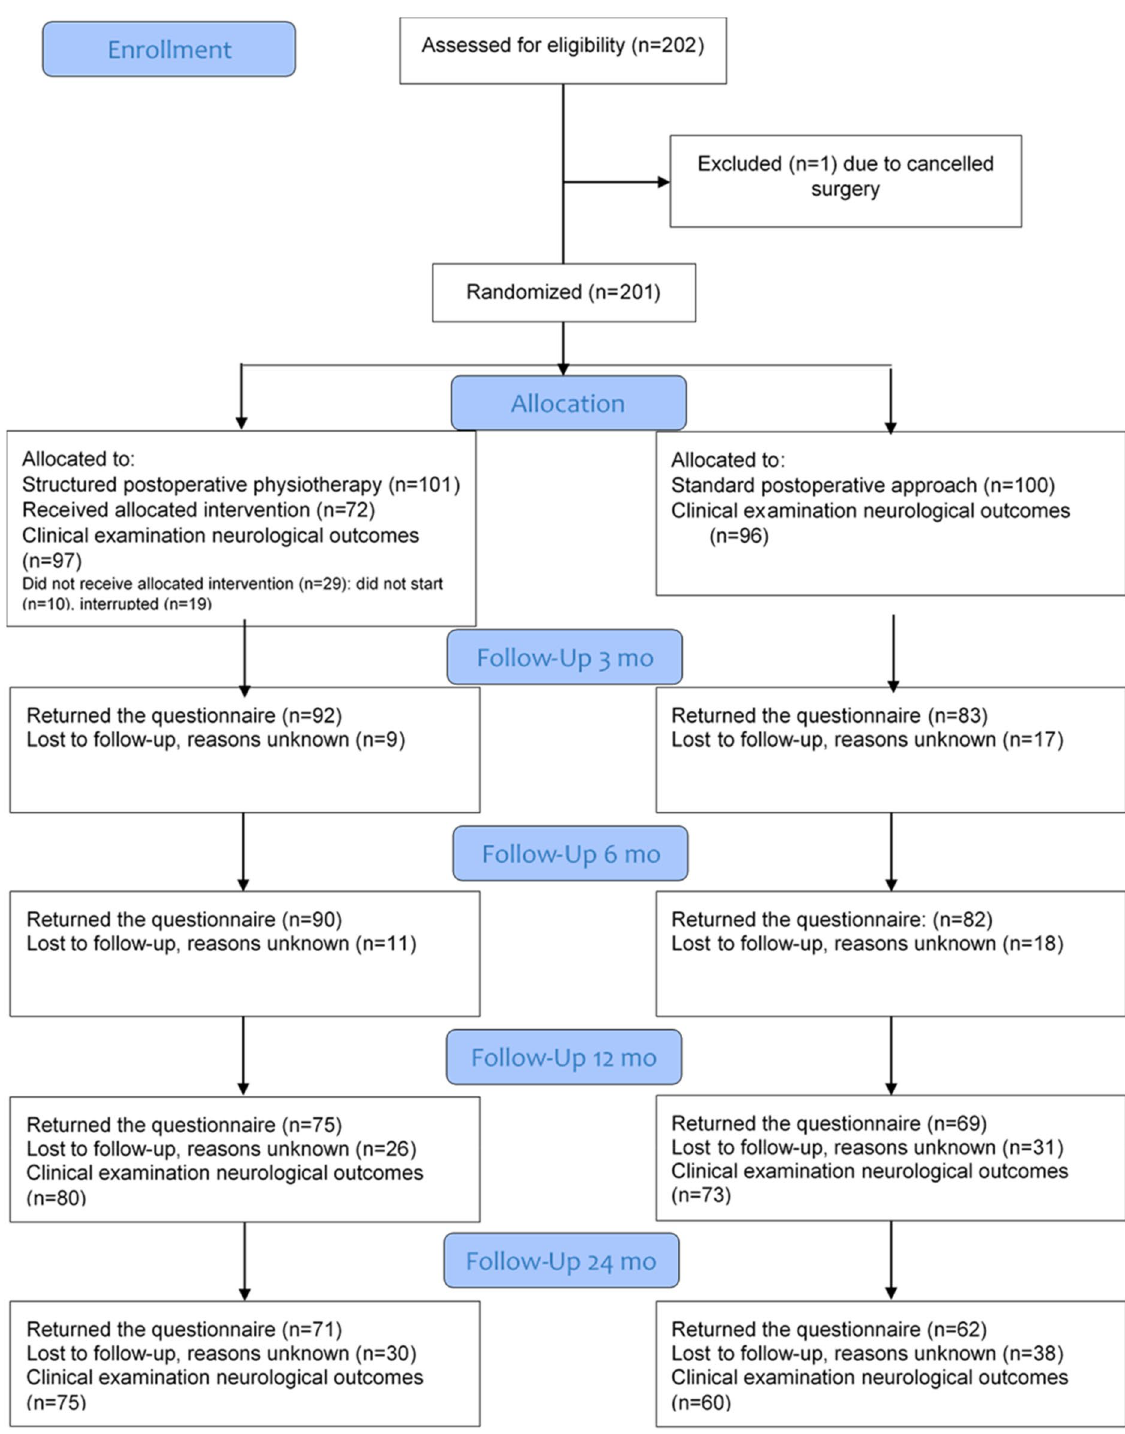
Figure 1. Flow chart of participants included in the analyses of secondary neurological